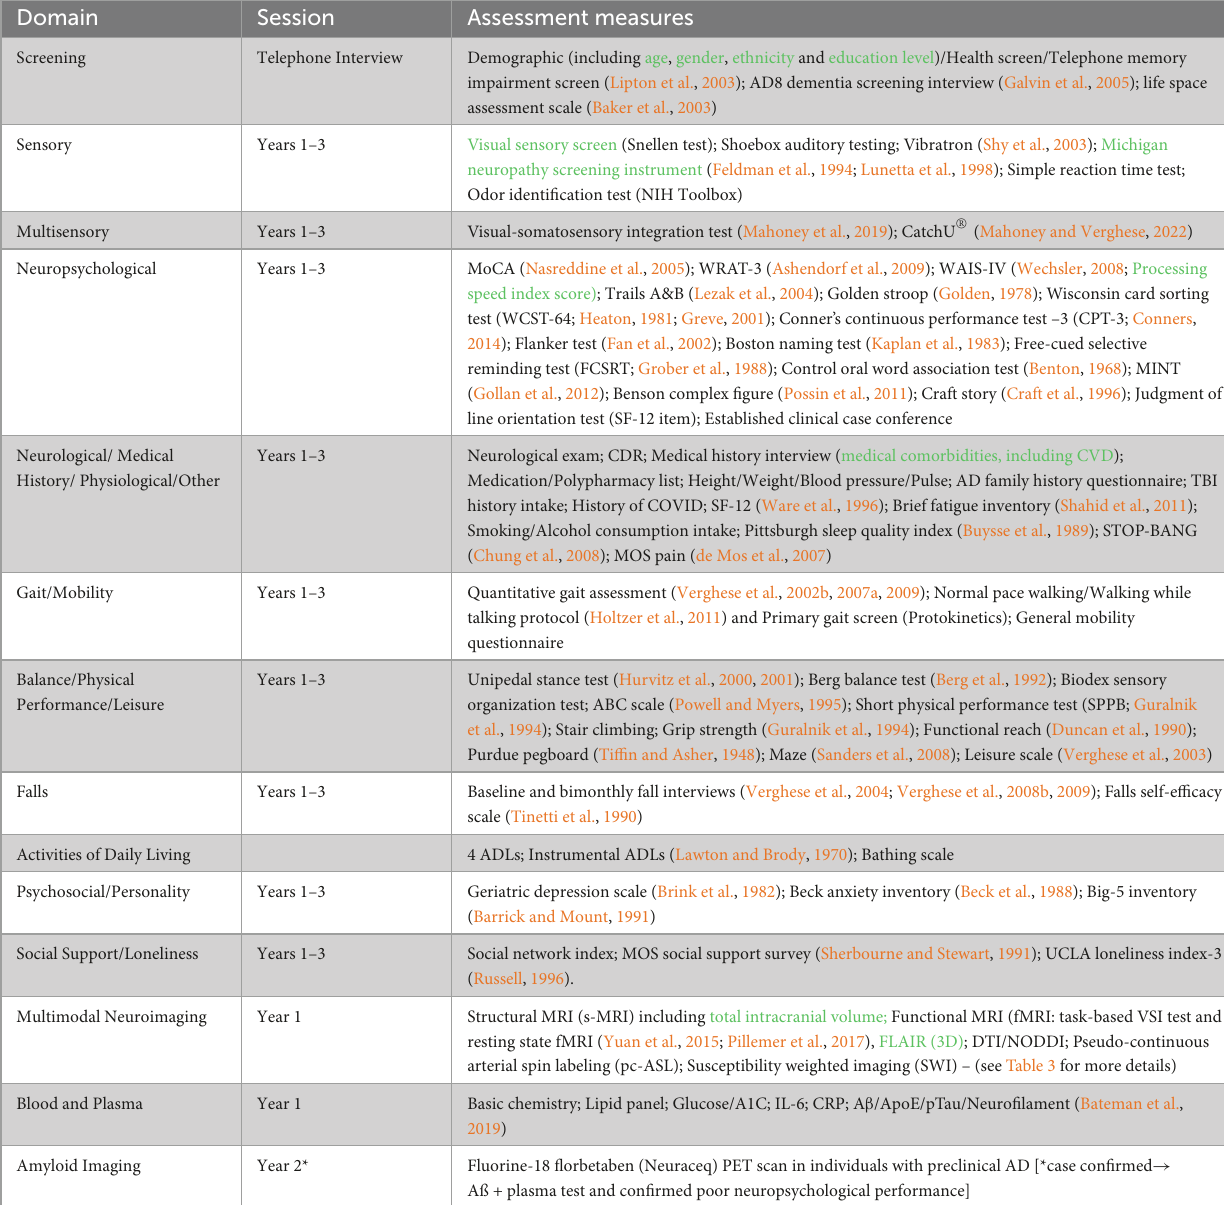
TABLE 2 Assessment measures by domain and session.